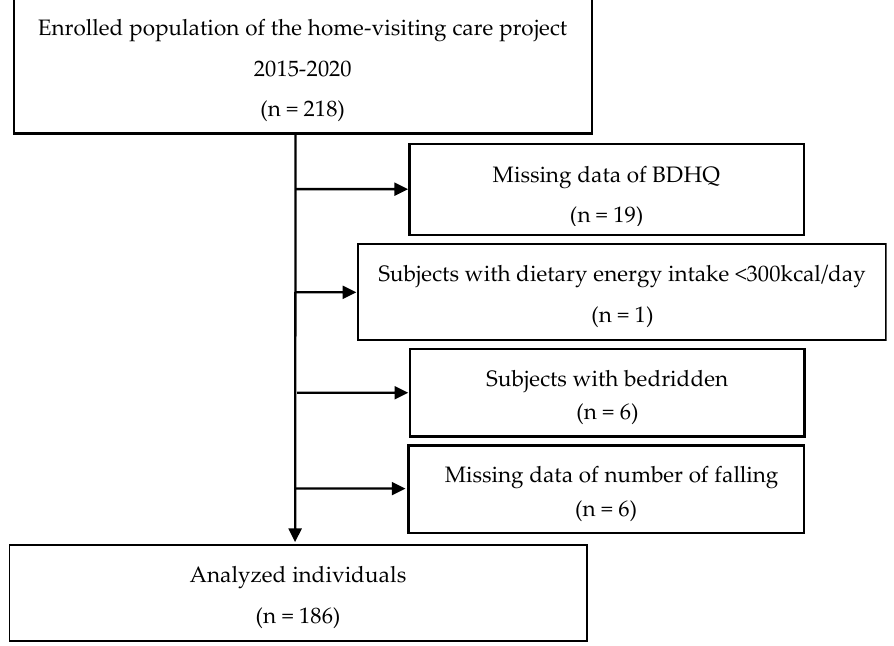
Figure 1. Flow diagram of participants selection.